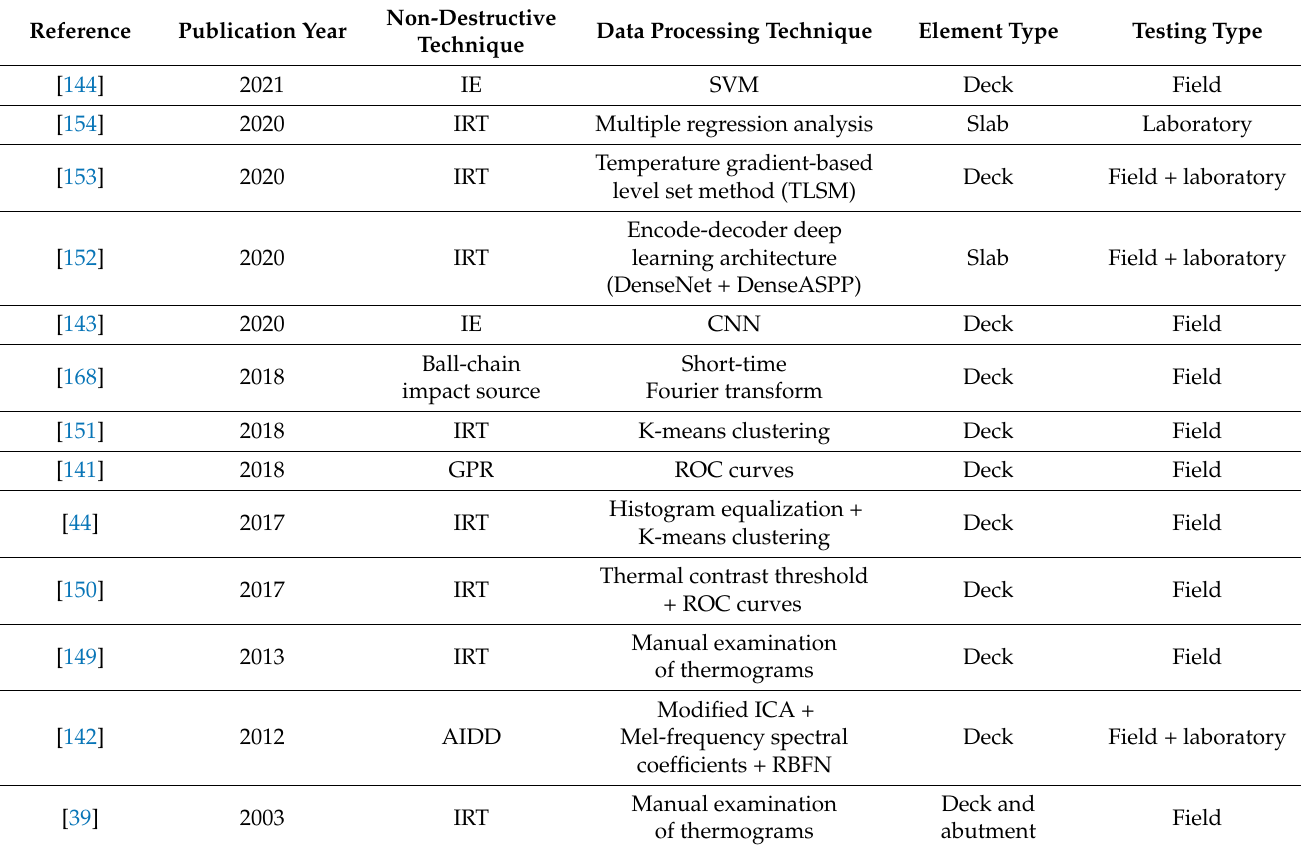
Table 14. Review of some of the research studies on delamination detection and